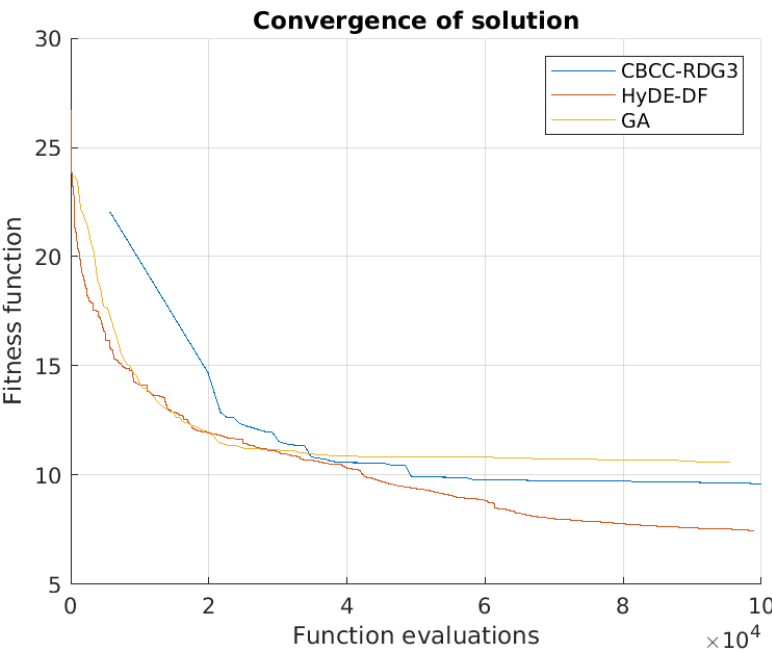
Fig. 8: 10 5 func. evaluations; CBCC-RDG3: 9.6103; HyDE-DF: 7.463; GA: Figure 8. 10 5 func. evaluations; CBCC-RDG3: 9.6103; HyDE-DF: 7.463; GA: 10.5938